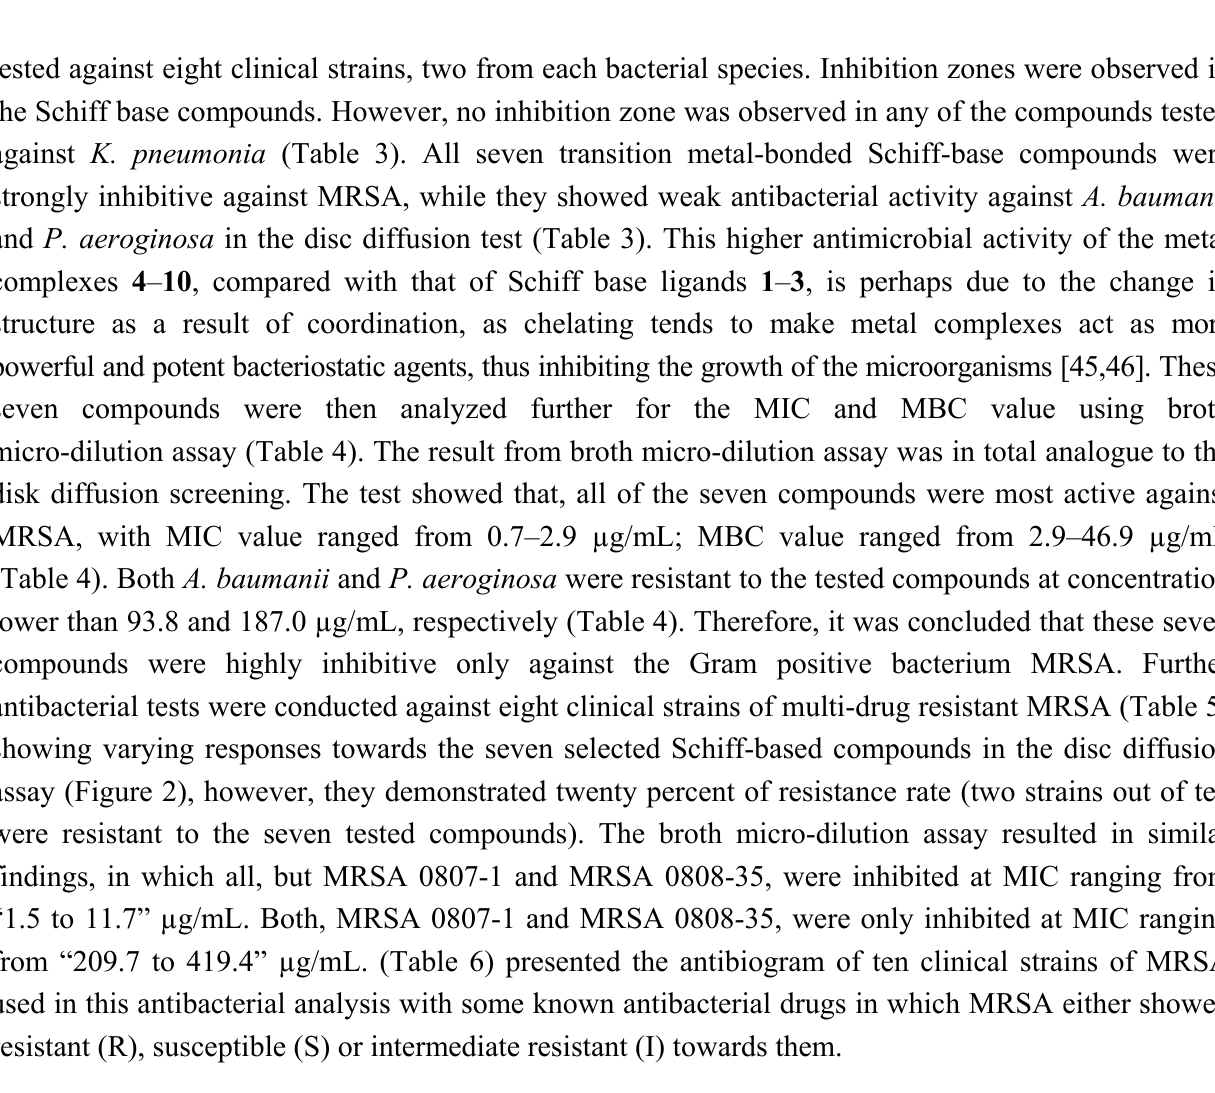
Table 3. First level antibacterial screening Disc diffusion